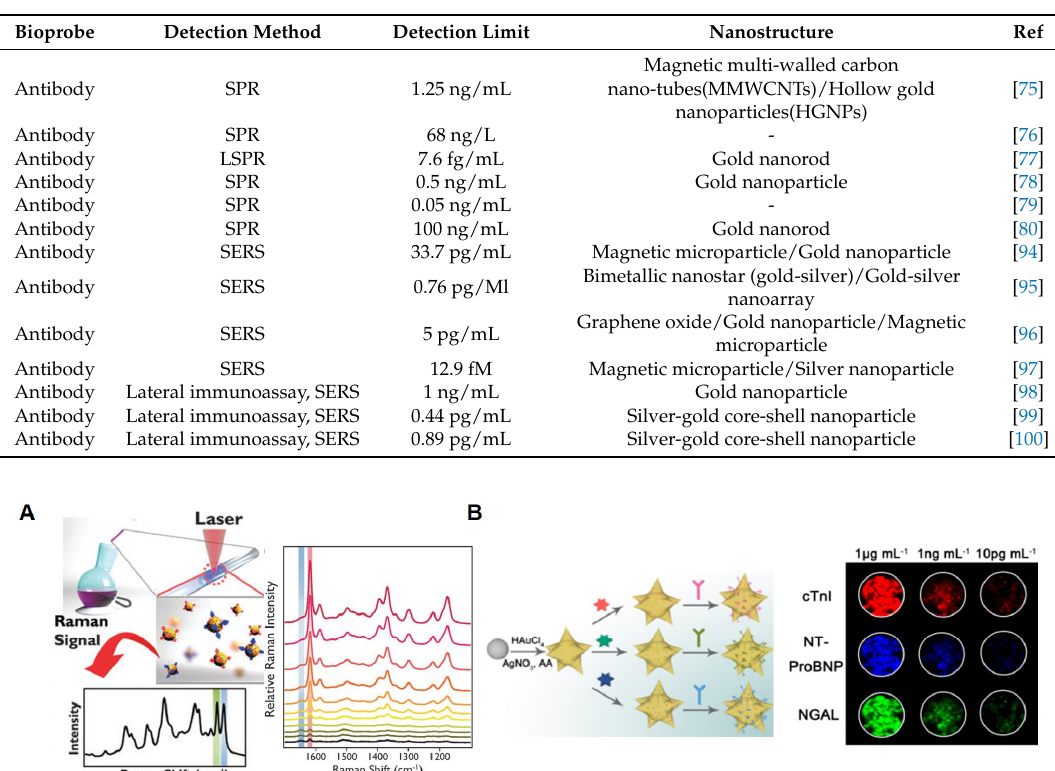
Table 2. Comparison of the SPR-based TN biosensor and SERS-based TN biosensor in terms of the bioprobe, detection method, detection limit, and nanostructure.